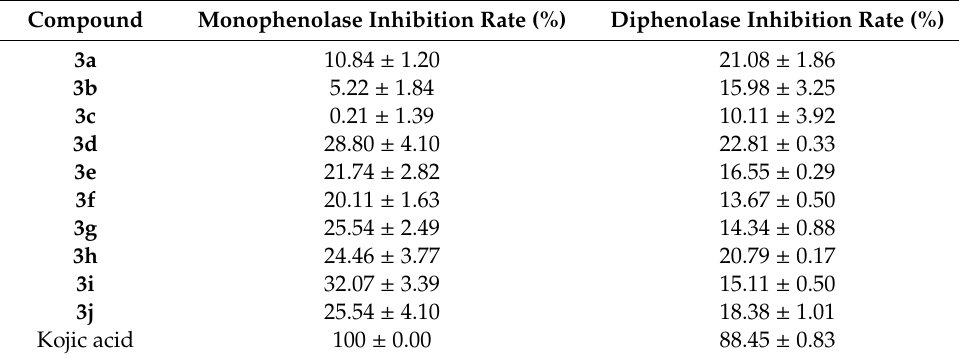
Table 2. Tyrosinase inhibiting activity of synthesized compounds